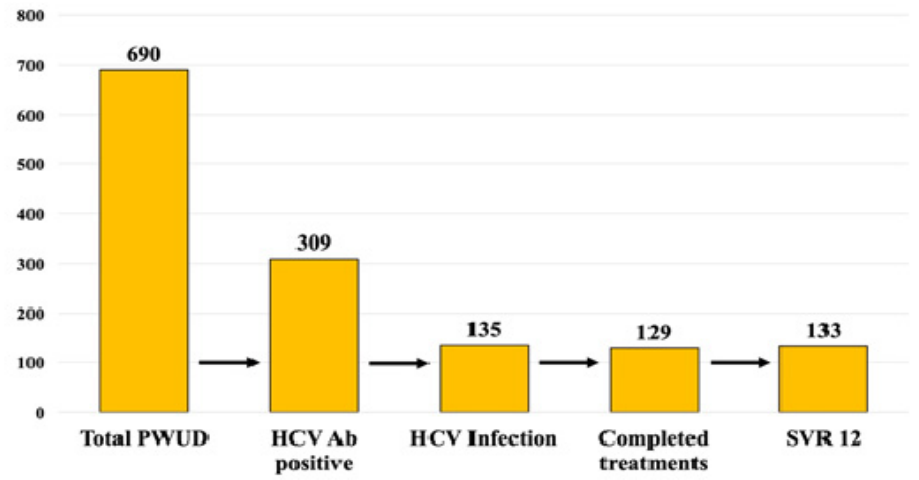
Figure 2. HCV care cascade. 309 PWUDs, 44.8% of total patients tested, were HCV Ab positive and of this, 135 (43.7%) had a detectable HCV RNA. All patients with an active HCV infection started the antiviral treatment, but 6 patients dropped out in the first month. Despite the interruption of the treatment, none of these patients were lost to follow-up and only 1 did not achieve the virological response at week